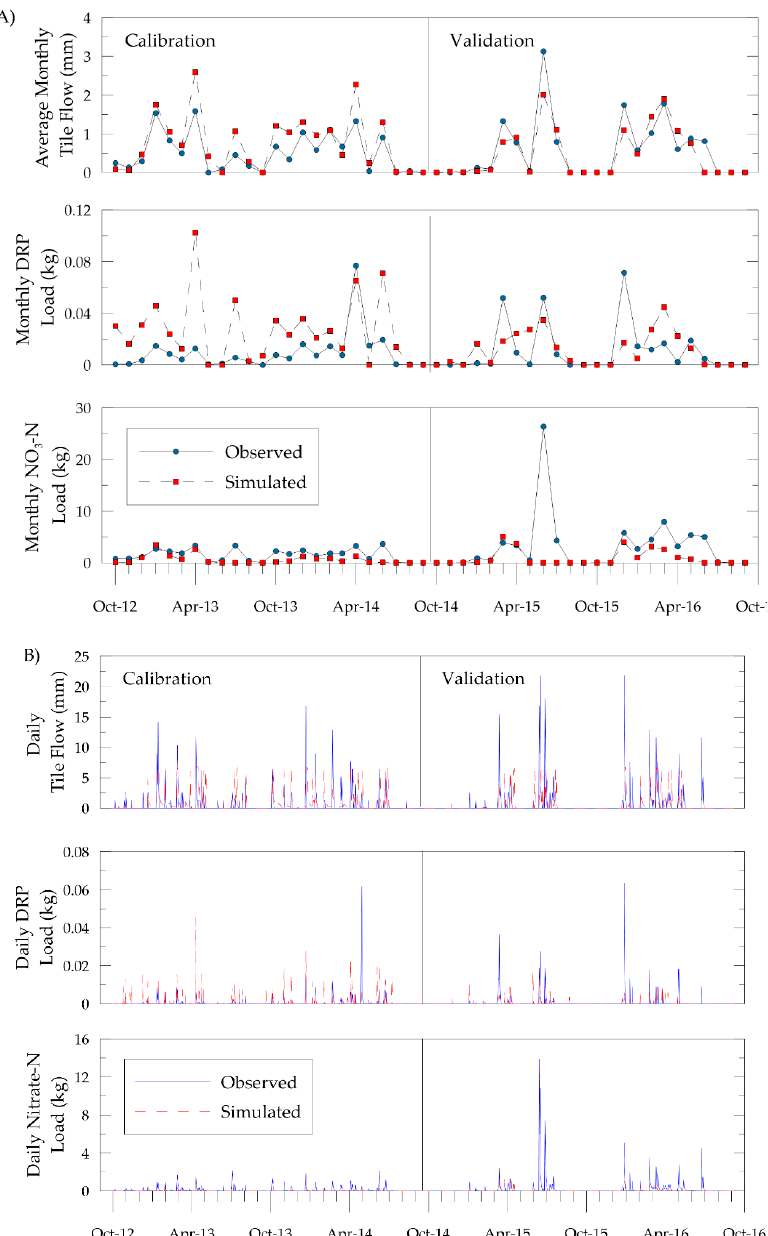
Figure 6. Comparison of ( A ) monthly and ( B ) daily simulated and observed tile flow, nitrate-nitrogen in tile flow, and dissolved reactive phosphorus (DRP) in tile flow at the tile monitoring station in Eagle Creek watershed, Ohio.